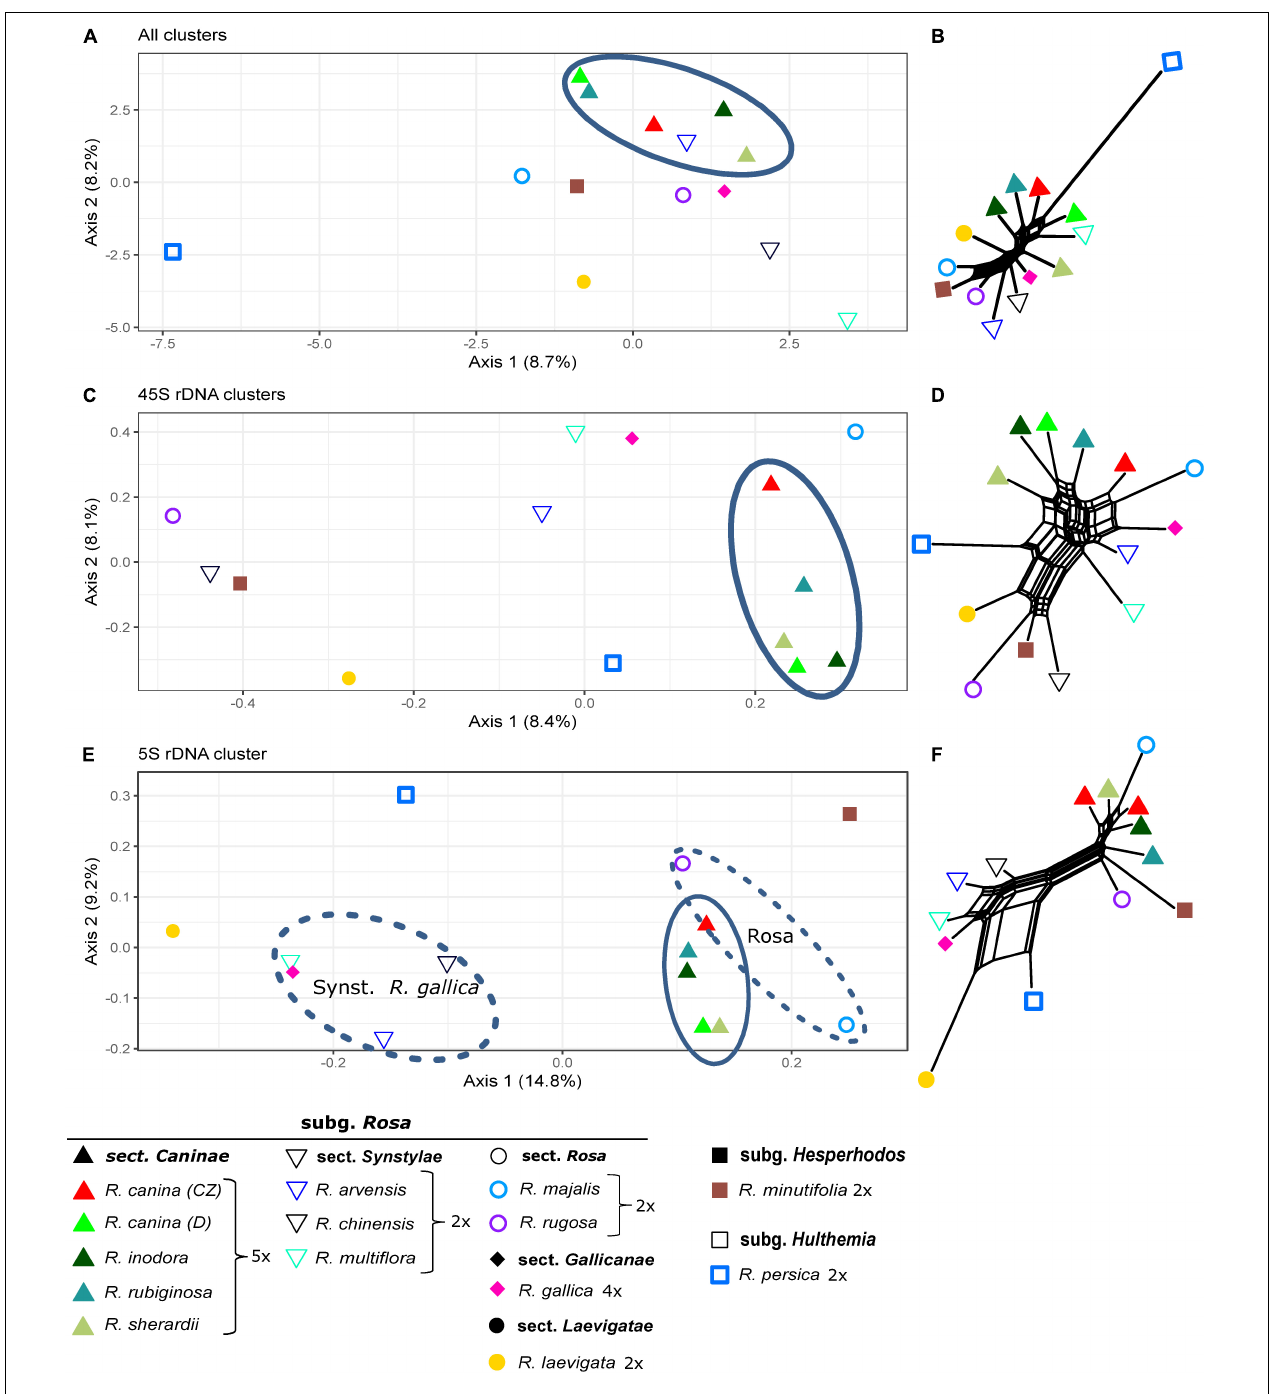
FIGURE 7 | Principal Coordinate Analyses of Rosa species based on inverted and summarized observed/expected matrices from comparative RepeatExplorer2 output and neighbor nets based on Gower distances calculated from those comparative RepeatExplorer2 outputs. Axis percentages explain the variance on the first two dimensions. (A) PCoA and (B) the neighbor net across all 297 clusters, (C,D) only those four with 45S rDNA hits, and (E,F) Cluster 107 with 5S rDNA hits. Oval – Rosa section Caninae . The oval dashed line indicating Synstylae , R. gallica , and the sect. Rosa phylogenetic signal in the 5S rDNA cluster.